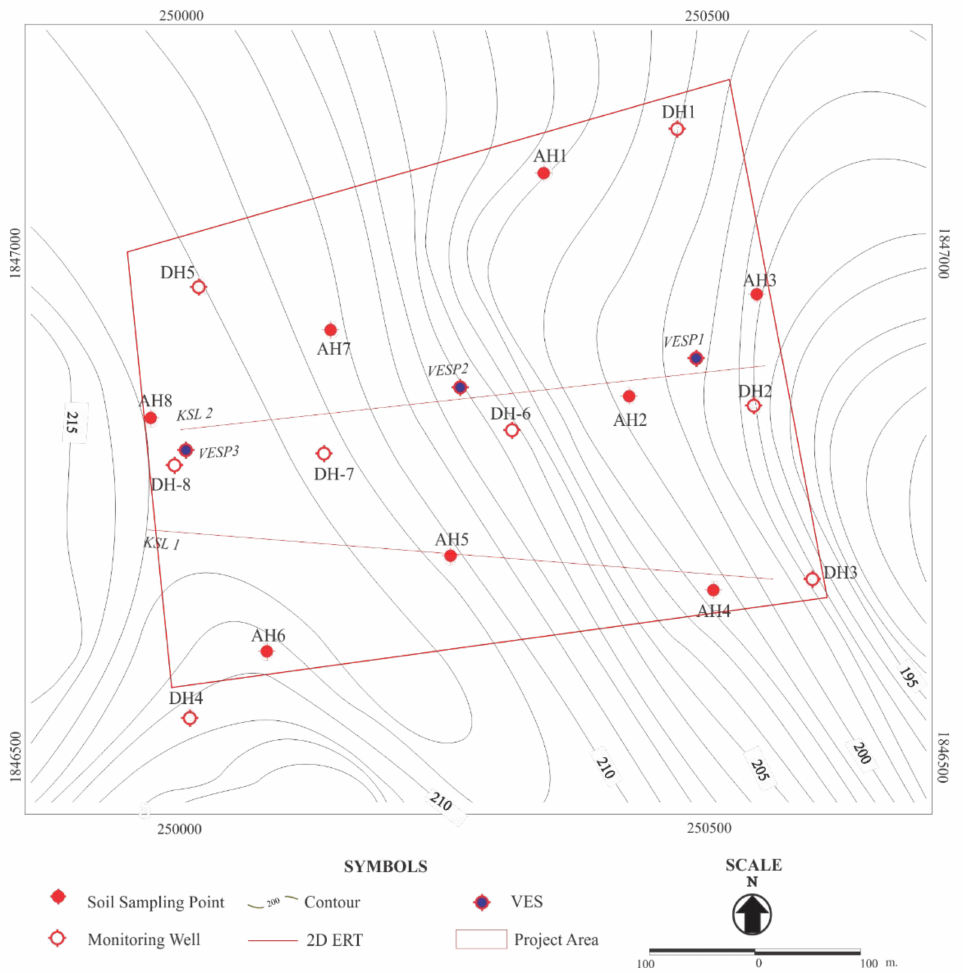
Figure 3. Schematic plan of sampling locations and survey